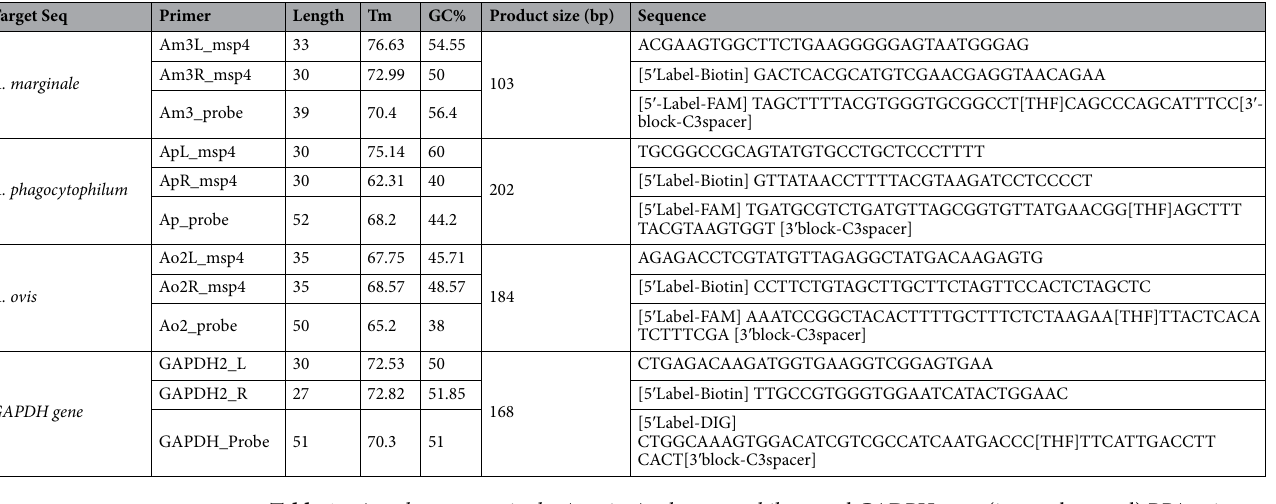
Table 1. Anaplasma marginale, A. ovis, A. phagocytophilum, and GADPH gene (internal control) RPA primers and probes*. *Primers, probes, and the amplification kit are protected by a patent